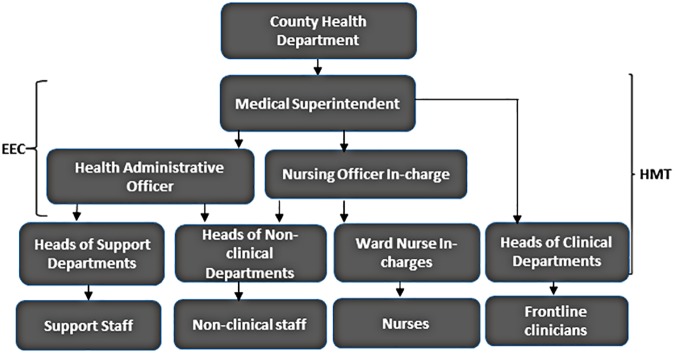
Hospital organogram.